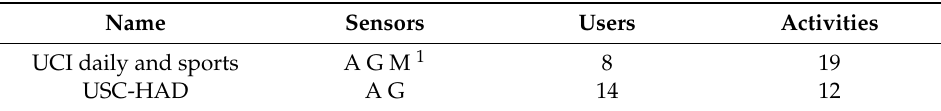
Table 1. Information of the datasets we used. The link of them is on the name.